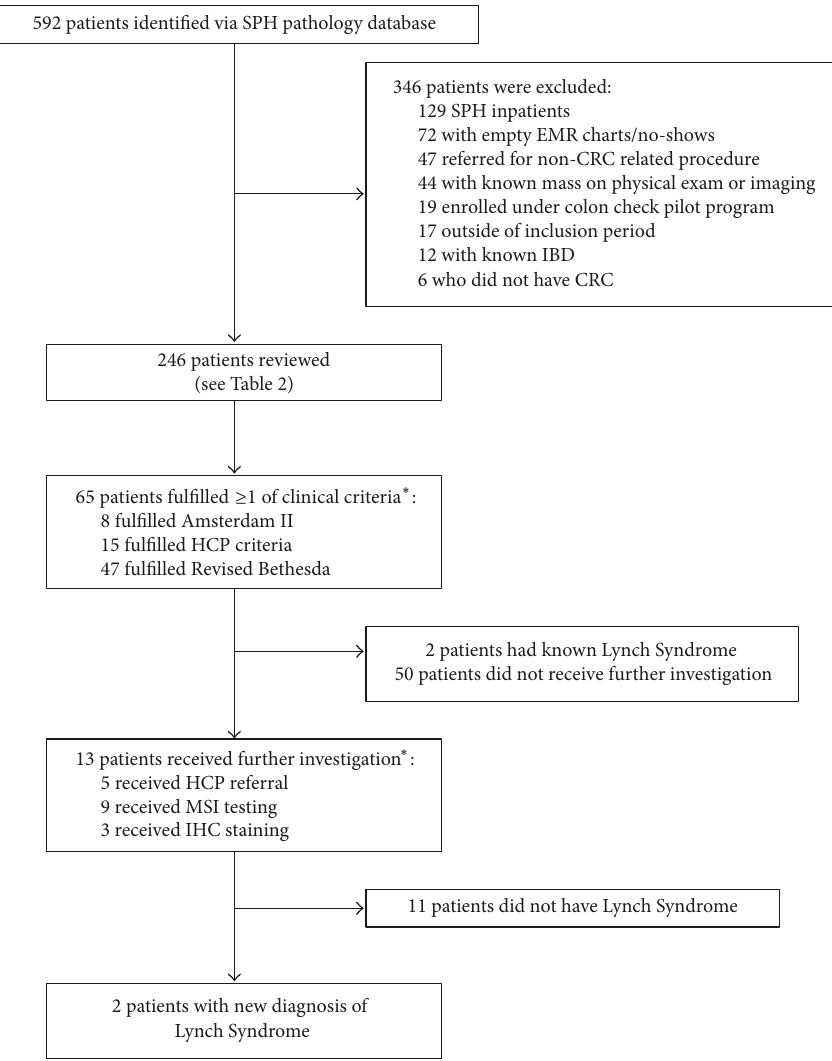
Figure 1: Flow chart of study and